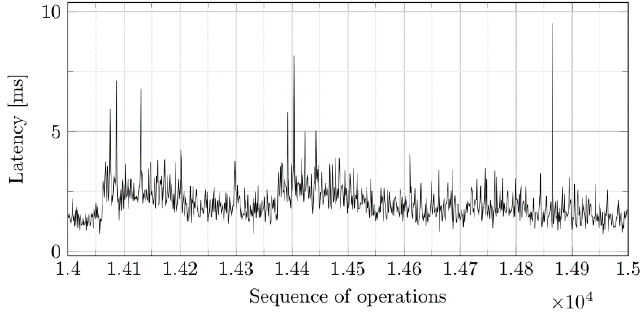
Figure 15. Sequence of latency values measured within the 15th group of one thousand operations.